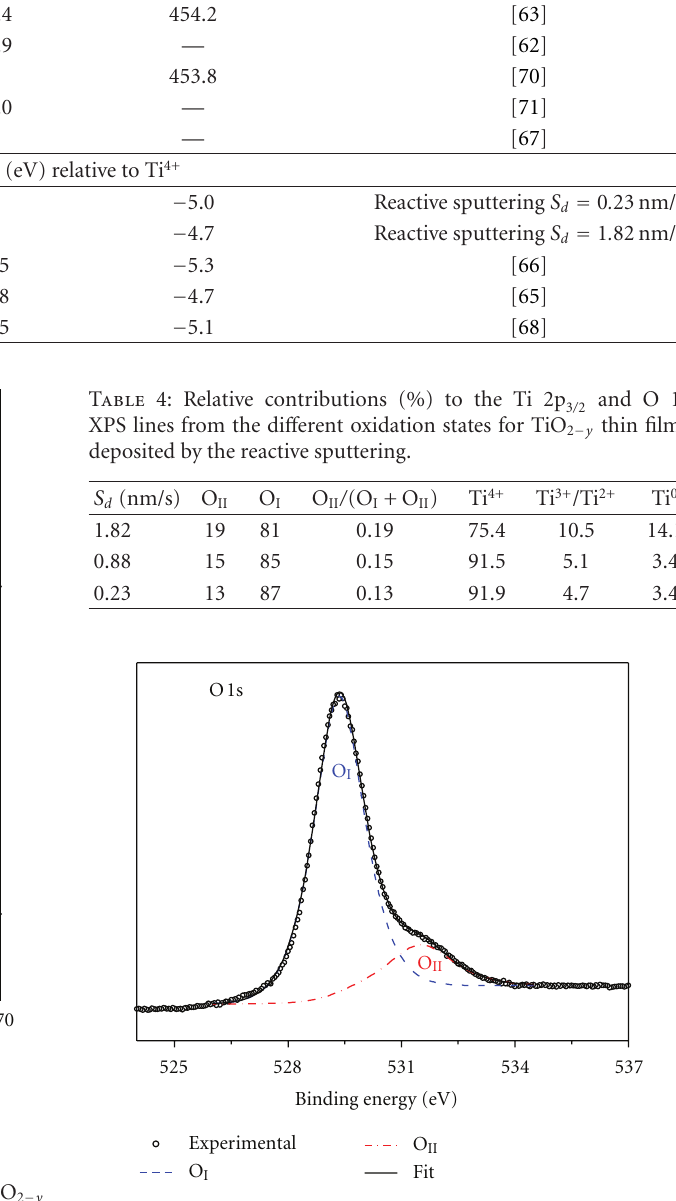
Figure 8: Fit of O 1s XPS peak for a TiO 2 − y thin film deposited by reactive sputtering onto Si wafer at S d = 0 . 23